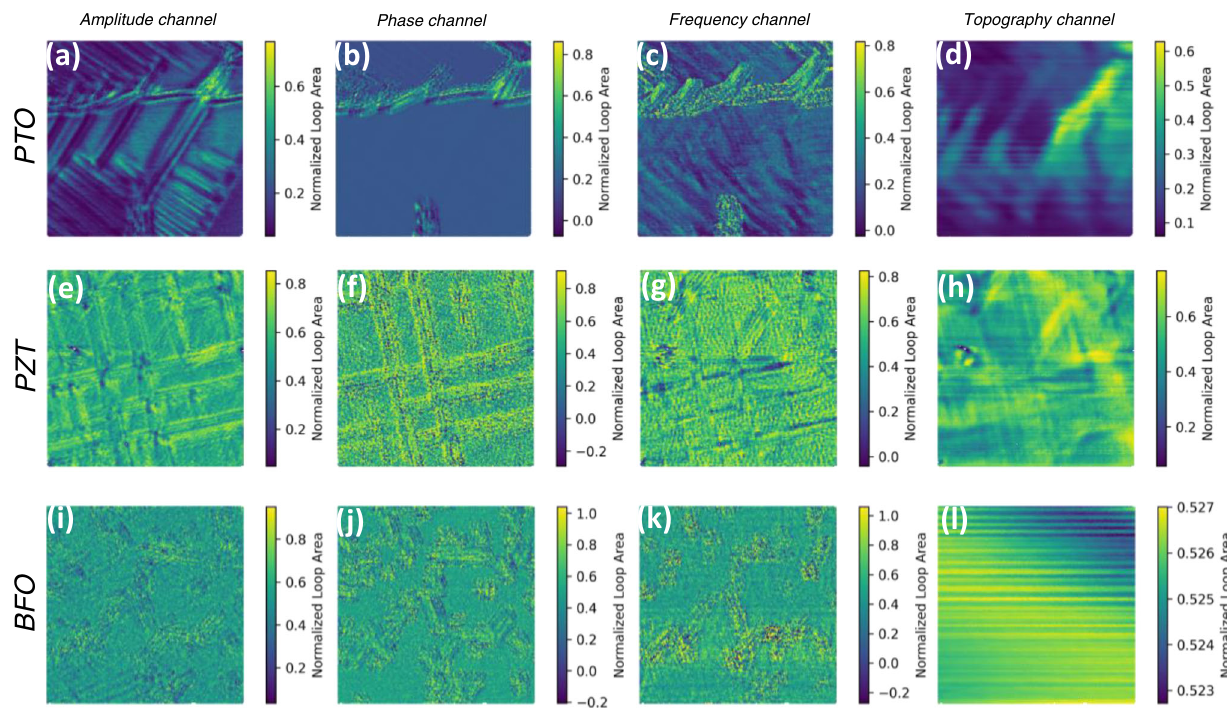
Fig. 4 Ensemble DKL prediction of polarization loop area from each channel after experiment. a – l Ensemble DKL predictions of PTO, PZT, and BFO, respectively. a , e , i DKL prediction from amplitude image; b , f , j DKL prediction of polarization loop area from phase image; c , g , k DKL prediction of polarization loop area from resonance frequency image; d , h , l DKL prediction of polarization loop area from topography